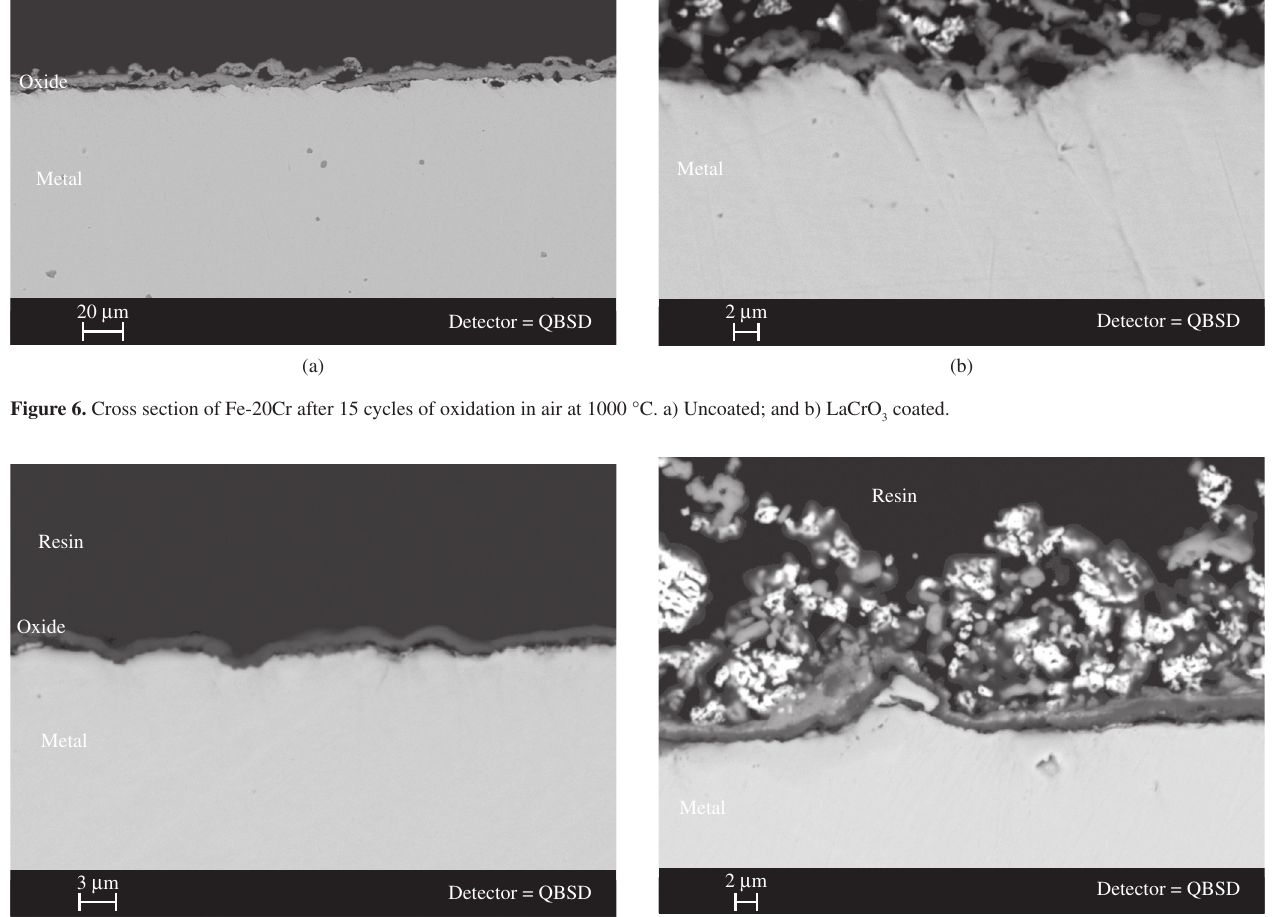
Detector = QBSD 3